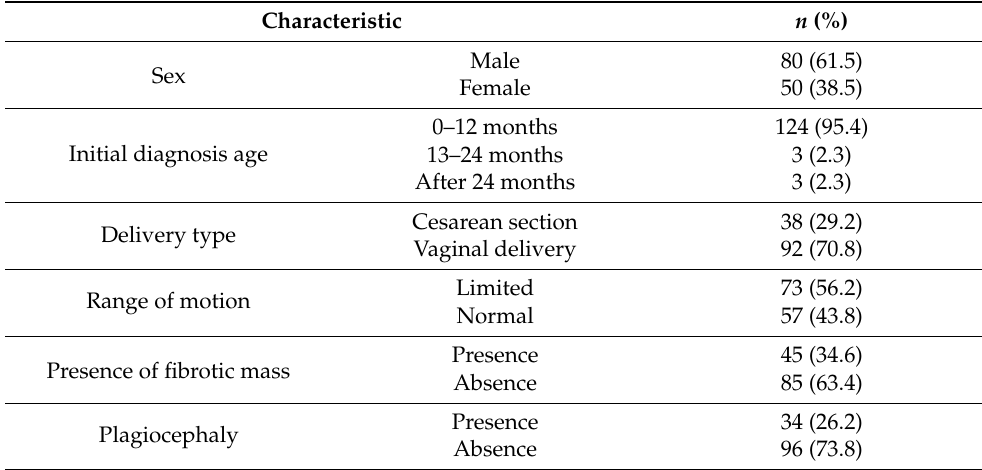
Table 1. Characteristics of children with CMT ( n =